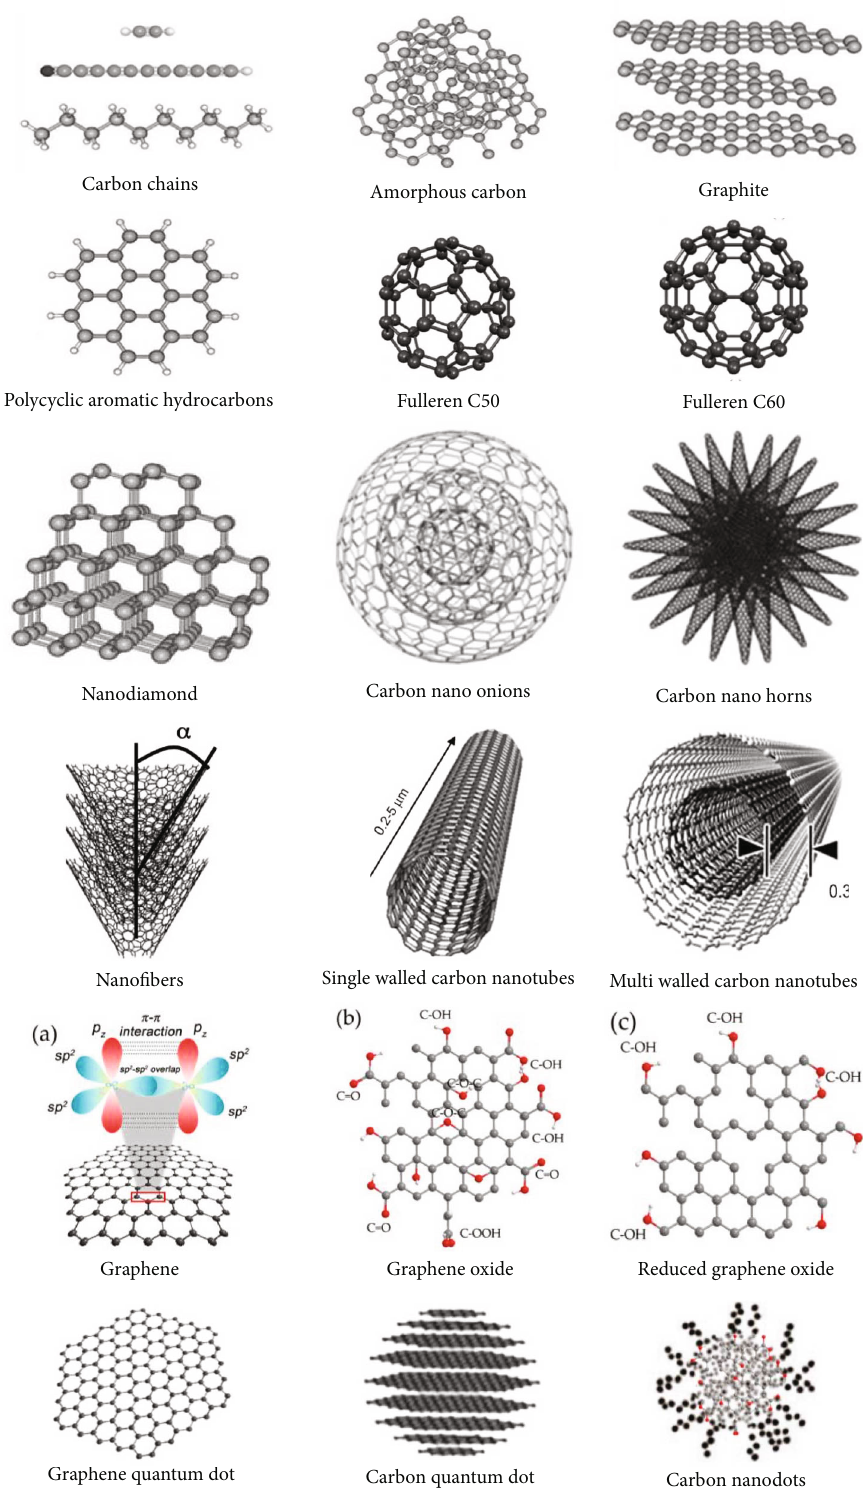
Figure 1: Description of the structure forms of carbon materials. Adapted from [35, 186 –